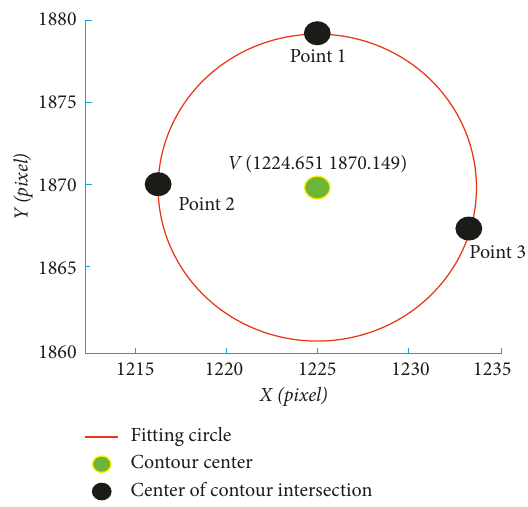
Figure 6: Point circle fitting results.